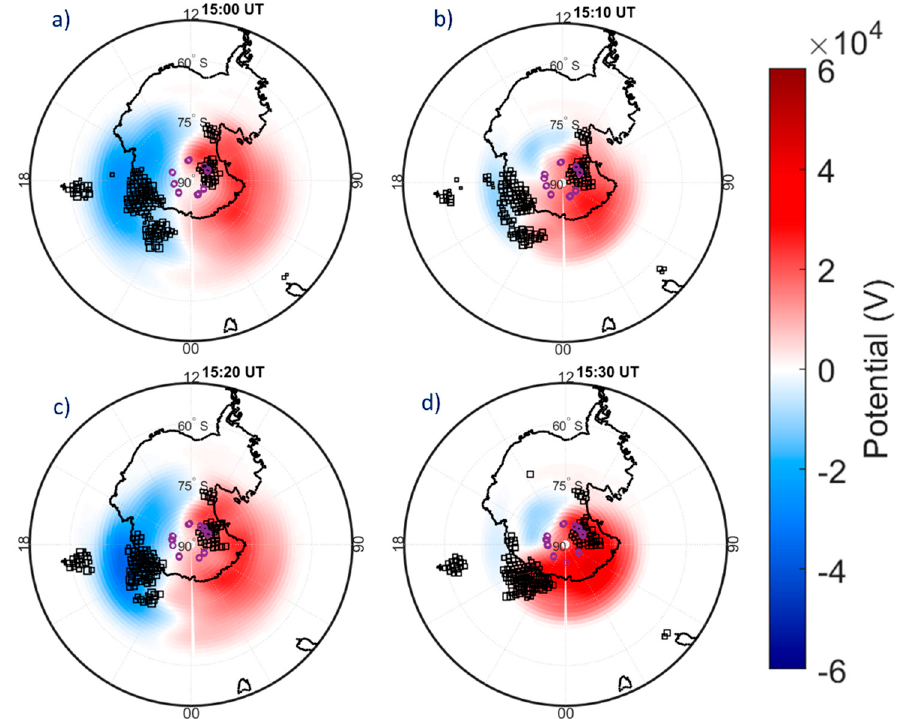
Figure 13. Polar-view maps in AACGM latitude and MLT of SuperDARN observations at 15:00 UT ( a ), 15:10 UT ( b ), 15:20 UT ( c ) and 15:30 UT ( d ) on 8 September 2017. Each map shows the isocontours of the ionospheric potential (red = positive, blue = negative potential) and the location of SuperDARN measurements (black squares) recorded in the two minutes following the time shown at the top of each map. In each map the projection to 350 km of altitude of all the σ φ values having elevation angle α = 30° (purple circles), recorded by the GNSS receiver at Concordia in the same time interval as for SuperDARN observations are also shown. In each map, which covers 00:00–24:00 MLT and |50°|–|90°| AACGM Lat, the magnetic noon/midnight is at the top/bottom.